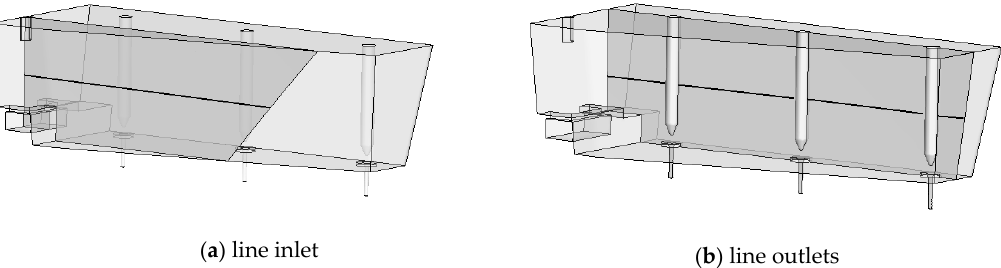
Figure 15. Location of measuring lines: ( a ) passing through the shroud, ( b ) passing through the SENs.